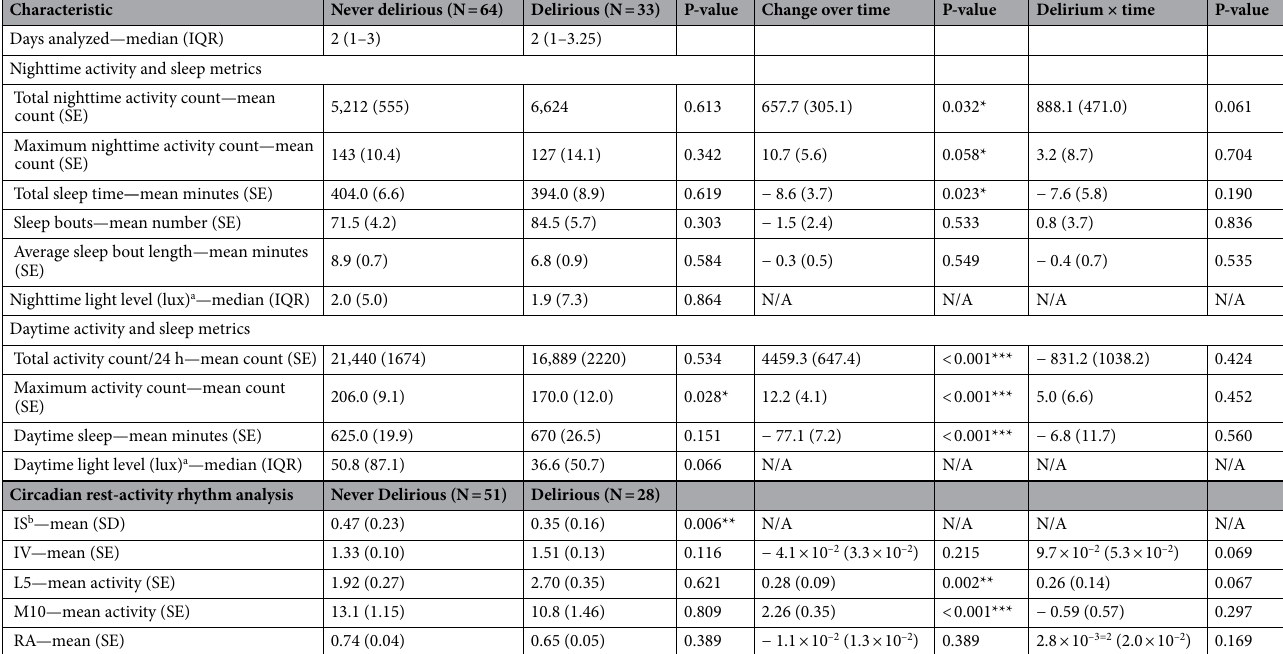
Table 3. Actigraphy data in never delirious vs. delirious patients. a Nighttime and daytime light levels between groups were compared using Mann–Whitney test. b Interdaily stability was compared using linear regression while all other metrics were compared using linear mixed effects